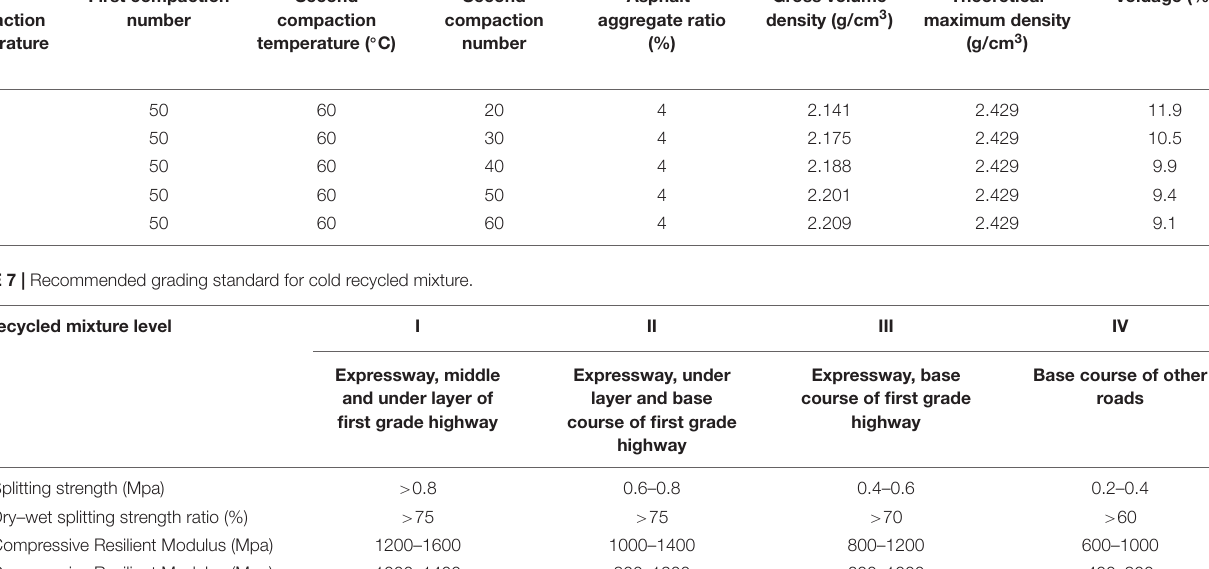
TABLE 6 | Test results of two compactions.